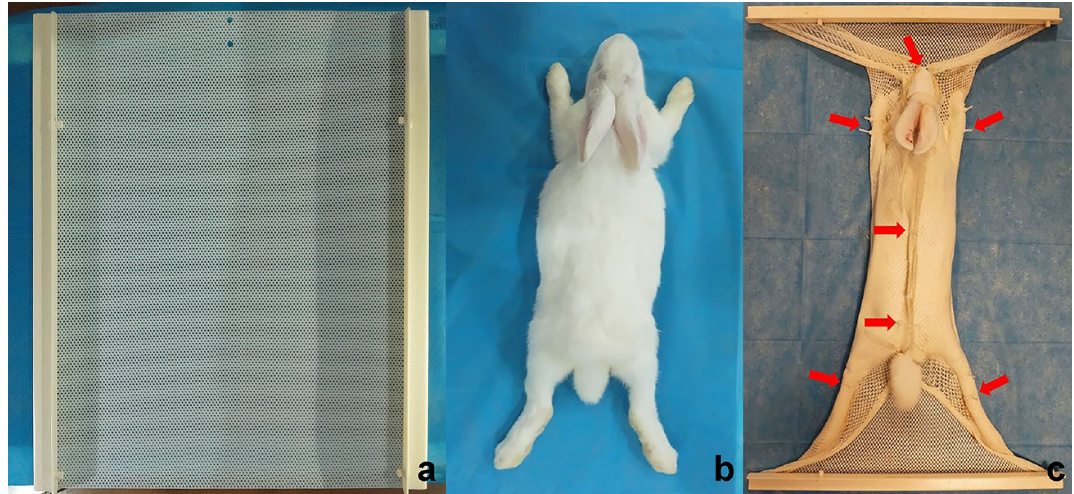
Figure 1. (a) : The overall shape of the thermoplastic mask before thermoplastic molding. (b) : The rabbit’s body position. (c) : The thermoplastic mask covered the entirety of the rabbit’s body, including its head and all of its limbs; the red arrows indicate the strapping tape